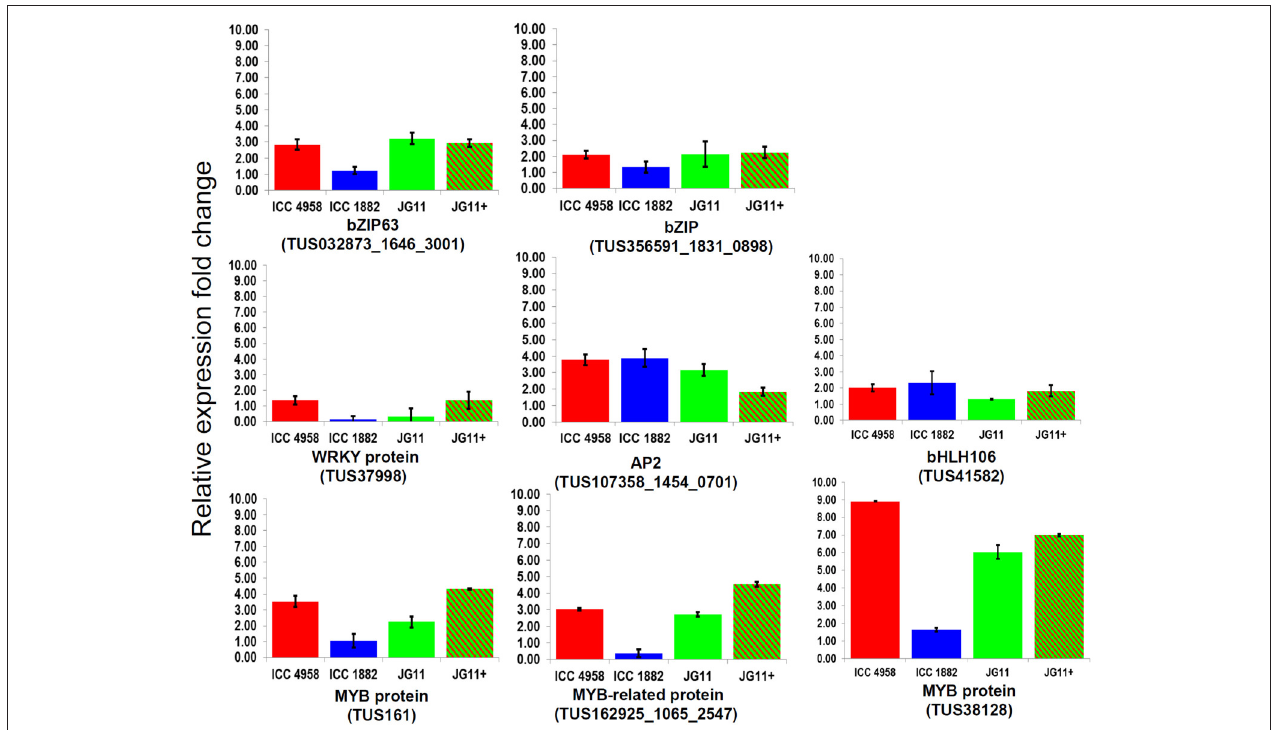
FIGURE 1 | The relative expression ratio of 8 candidate TF genes analyzed using qRT-PCR under drought stress. The relative expression ratio of each gene was calculated relative to its expression in control sample. GAPDH was used as an internal control to normalize the data. The error bars representing standard deviation were calculated based on three biological and two technical